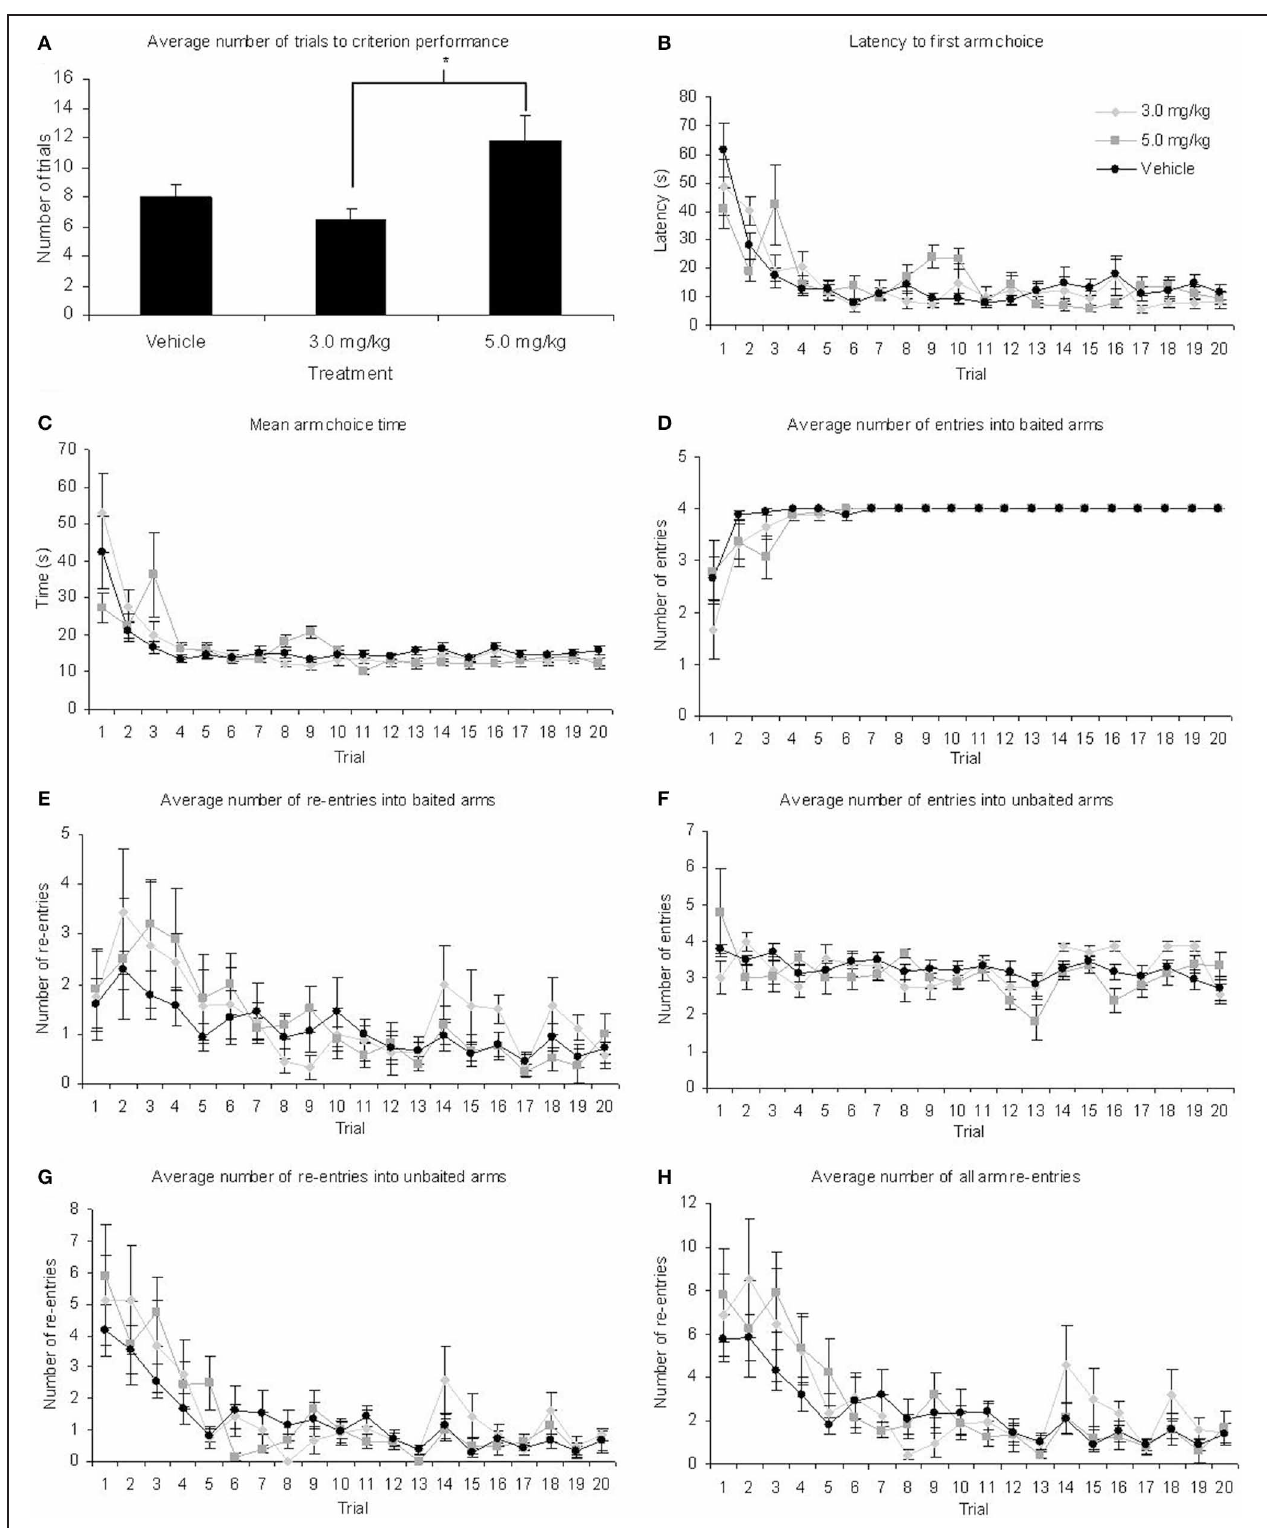
FIGURE 2 | (A) Rats treated with 5.0mg/kg MPH took significantly longer to reach criterion on the RFNDT than those treated with 3.0mg/kg although neither differed significantly from the vehicle-treated group. However, there were no significant main effects of treatment for any other measure of radial